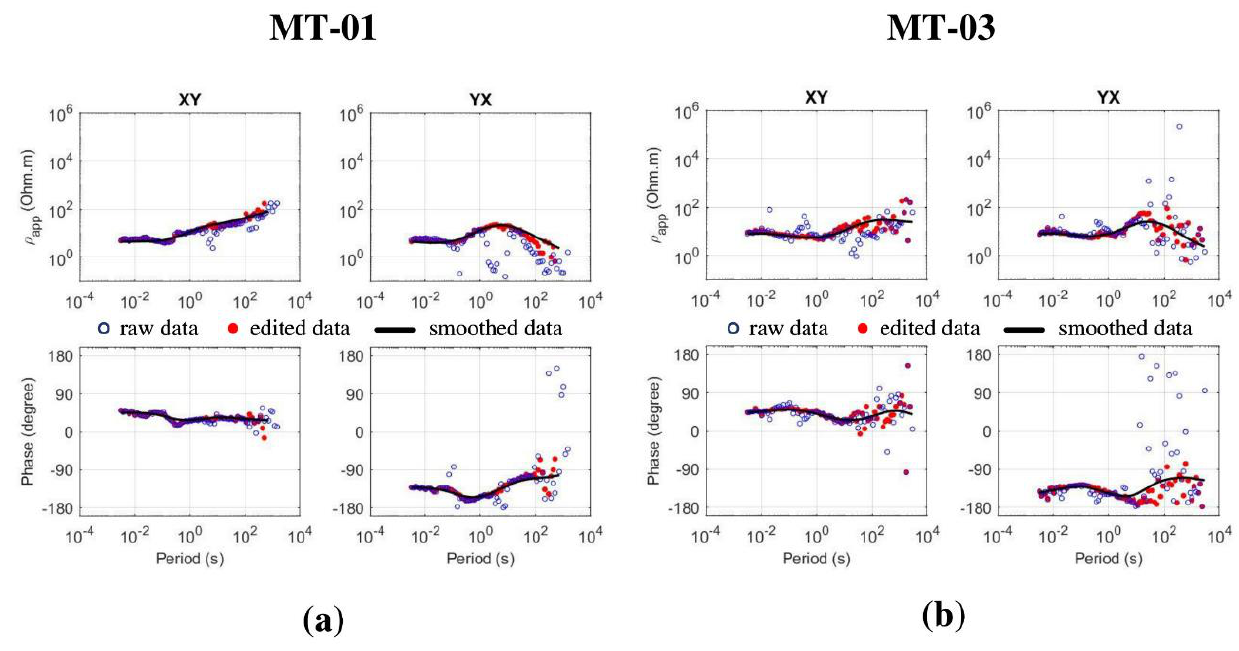
Figure 4. Examples of data processing for MT-01 and MT-03 data; ( a ) raw MT data and ( b ) data after cross-power selection and smoothing.